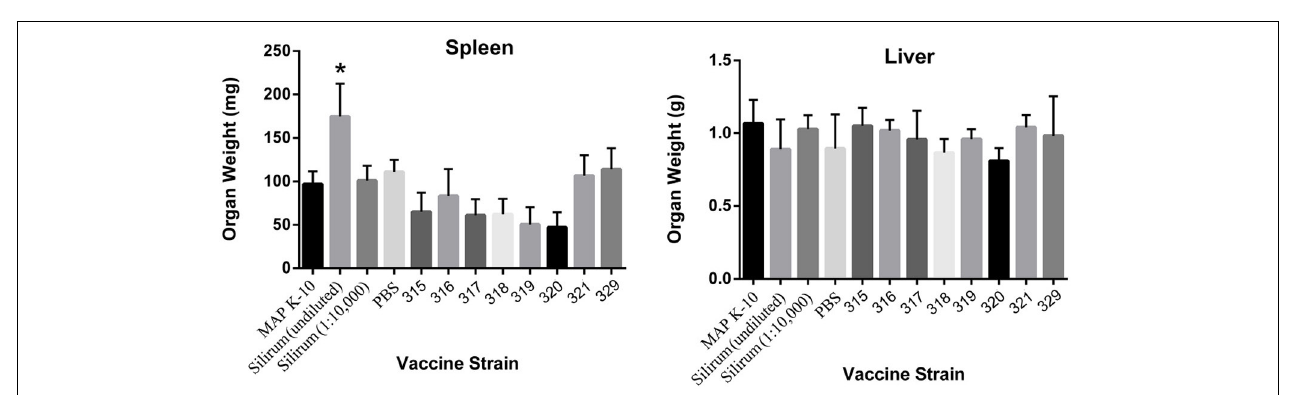
FIGURE 4 | Induction of splenomegaly in undiluted Silirum vaccinated mice at 18 weeks post vaccination. The graphs show the average spleen and liver weights of 5 mice per group. Statistically significant differences in spleen size of undiluted Silirum